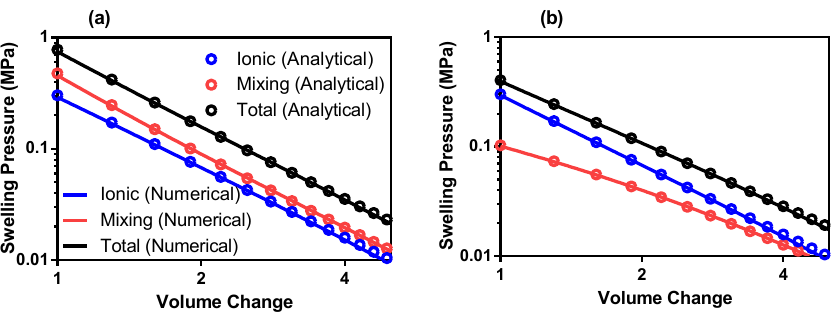
Figure 7. Model comparison to theoretical predictions of ( a ) univalent and ( b ) divalent solutions at φ s ,0 = 20%. Note: both axes are represented by a log scale for simplicity of visualization of a linear